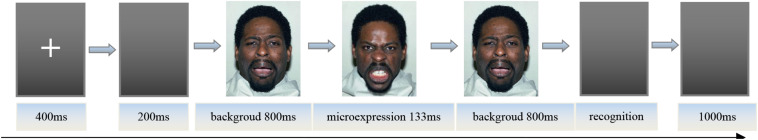
The picture of experiment procedure.